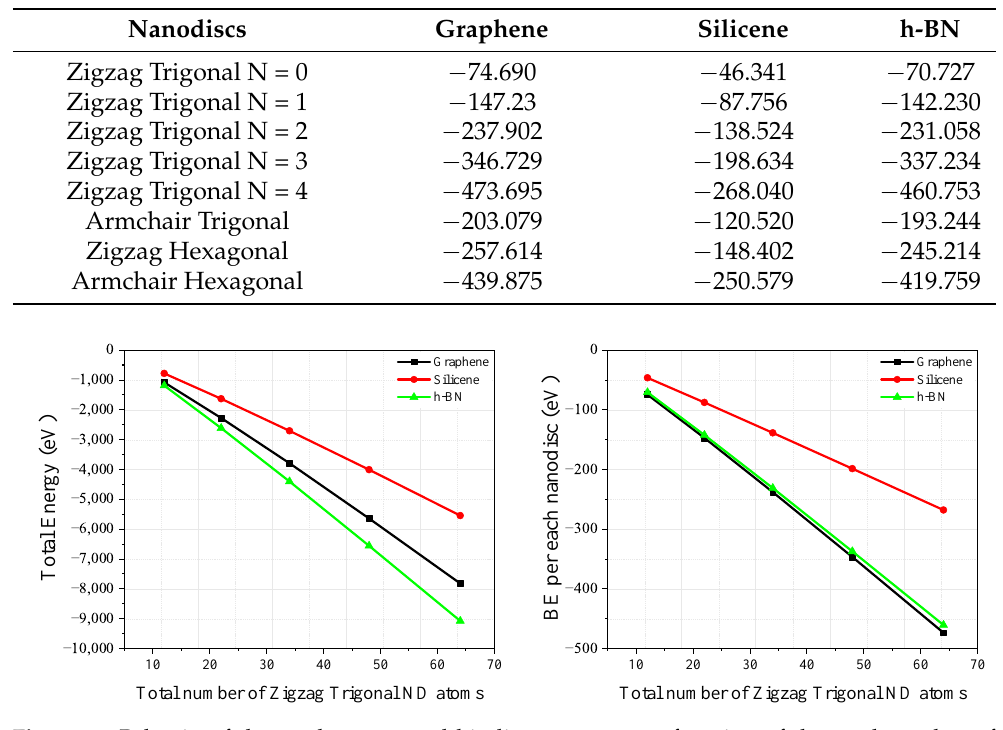
Figure 6. Behaviorof the total energy and binding energy as a function of the total number of constituent atoms of the zigzag trigonal